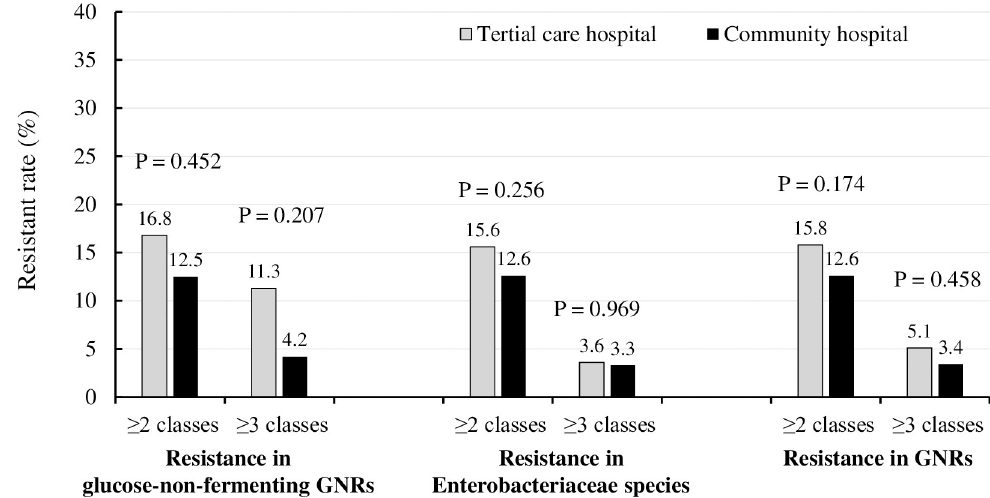
Fig 1. Resistant rate according to the European Committee on Antimicrobial Susceptibility Testing criteria in nosocomial isolates of Gram-negative rods (GNRs), glucose-non-fermenting GNRs and Enterobacteriaceae species between the tertiary care hospital and community